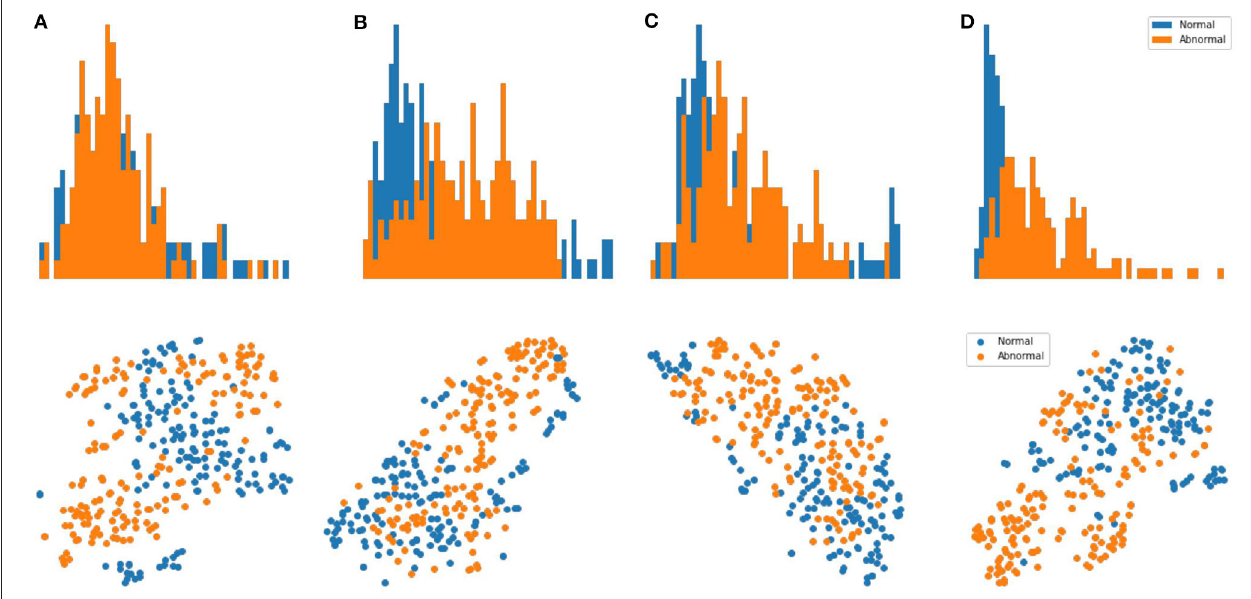
FIGURE 5 | Top Row: visualization of the embedding for all frames in the testing set of normal and abnormal videos using t-SNE. Bottom Row: Distribution of the frame-level anomaly score for all frames in the testing set of normal and abnormal videos. (A) MSC. (B) AMSC-CJ-RC. (C) AMSC-CJ-RR. (D) AMSC-CJ-WF.